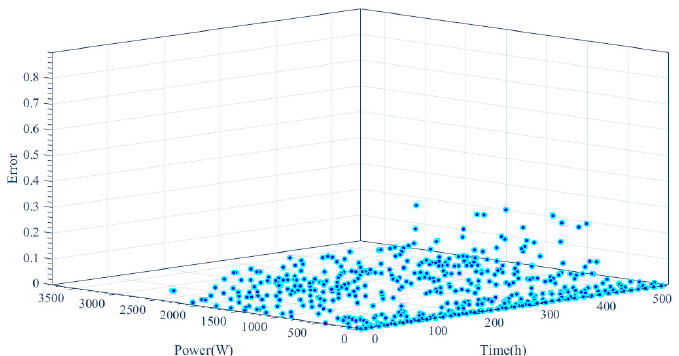
Figure 19. Error deviation calculated based on the forecasted over actual value.